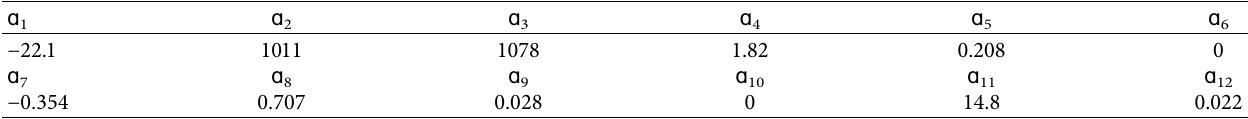
Table 1: Fitting parameter values of MF tire model.